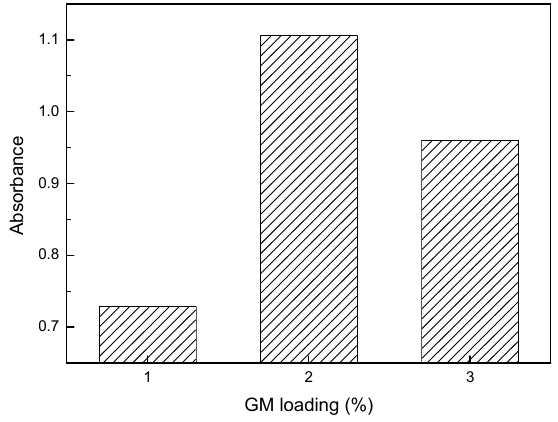
/ GM sol mixture at 660